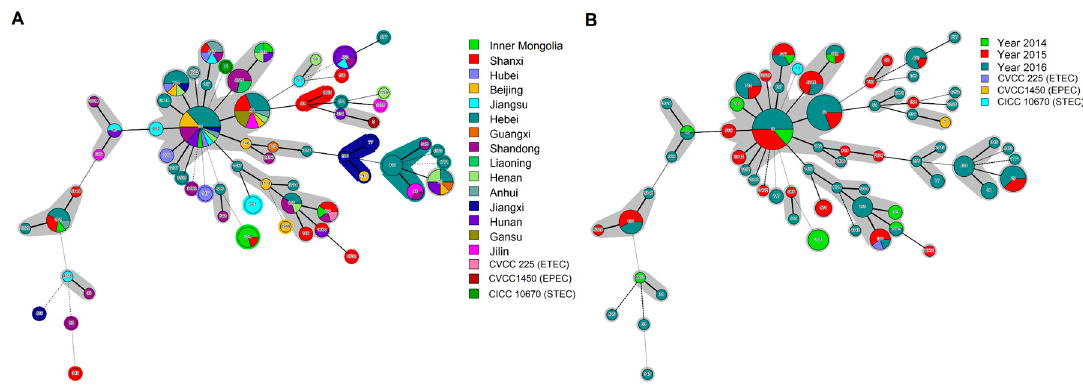
Figure 2. Minimum spanning trees showing the results of the multilocus sequence typing (MLST) of E. coli isolates in relation to geographic distribution and year of isolation. Three reference strains were included in the analysis. Each circle represents an ST and the size of the circle indicates the number of isolates of that particular type. The numbers in the circles represent the ST number. Solid lines denote the branch style coding up to 2, 3, and 4; dashed lines denote branch style coding up to 5; and dotted lines denote branch style coding above 5. The colors of the circles in the MLST trees indicate the MLST clonal complexes by province ( A ) and year of sampling ( B ).